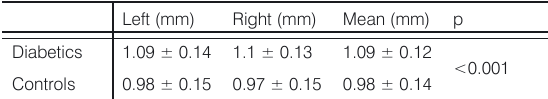
Table 2. An average CIMT in diabetics and healthy (Table 2 ). Due to our results, we decided to divide all the score.Left and duration of hypertension and diabetes). A p<0,05